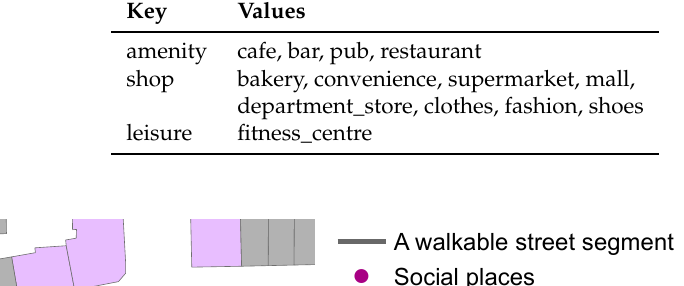
Table 1. OpenStreetMap tags considered to indicate a third place. Key Values